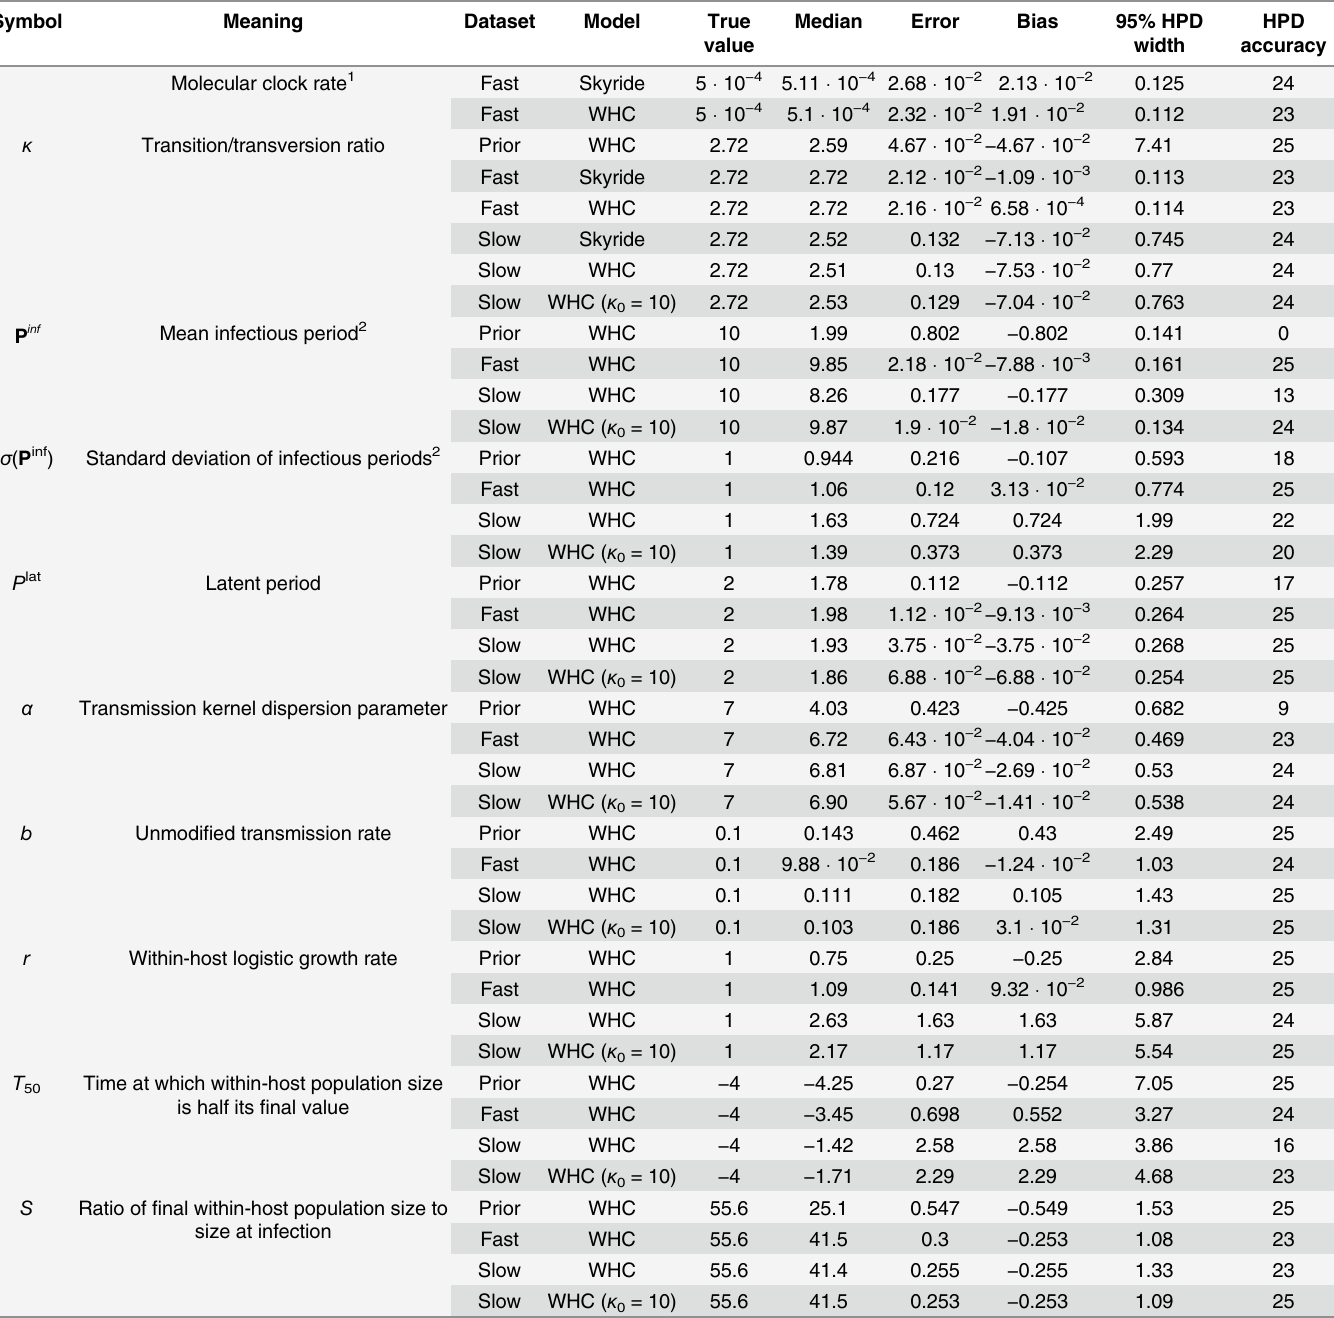
Table 5. Estimates of simulation parameters from the various analyses. The median values, across the 25 simulations, of the posterior median, relative error in the posterior median, relative bias in the posterior median and relative width of the 95% HPD interval of each parameter are given, along with the num- ber out of 25 simulations that the correct value was contained within the 95% HPD interval. Where estimates are not given for a particular analysis, this parameter was either fixed to its correct value or, in the case of WHC-related parameters in skyride analyses, not part of the analysis. Mathematical symbols are given where they are referred to in the text.